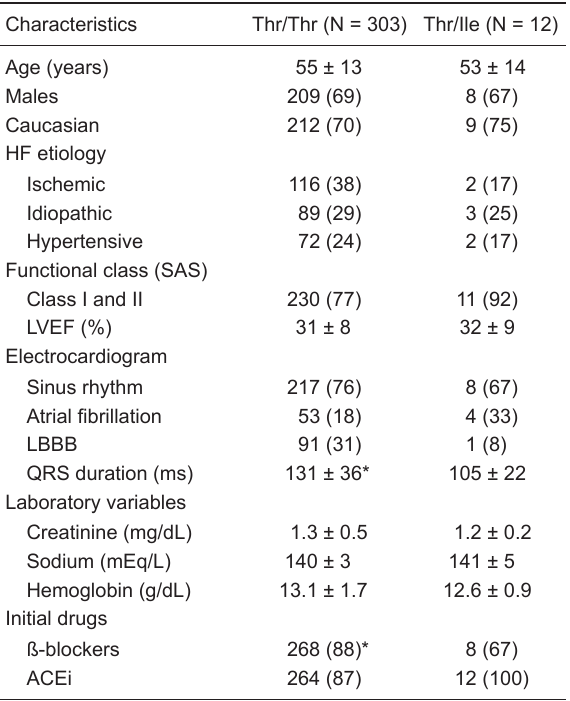
Table 2. Baseline clinical characteristics as a function of the Thr164Ile